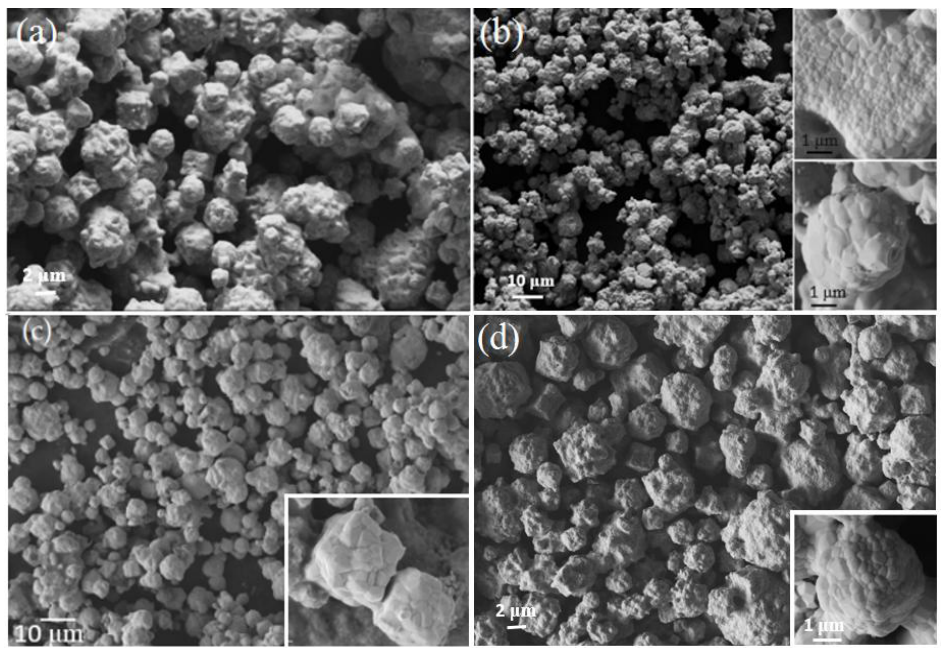
Figure 4. Scanning electron microscope (SEM) image of Ni-B powder from ( a ) Run 3, ( b ) Run 4, ( c ) Run 6, and ( d ) Run 8. Higher resolution SEM image shows ( c ) a cube and ( d ) sphere shaped morphology consisting of smoothly rounded crystals. Materials 2018 , 11 , x FOR PEER REVIEW